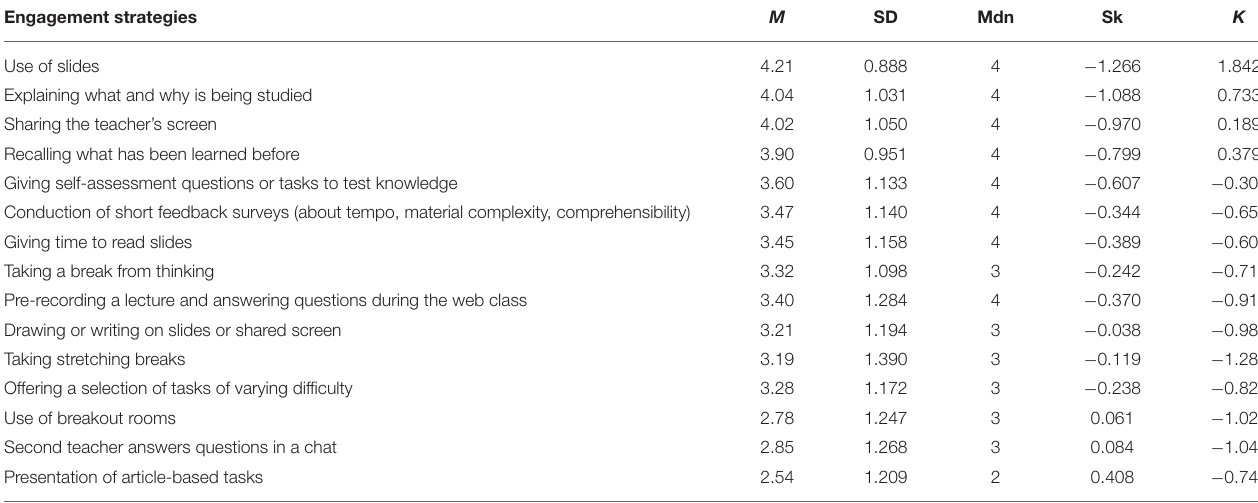
TABLE 2 | Descriptive statistics of ratings of student engagement strategies.